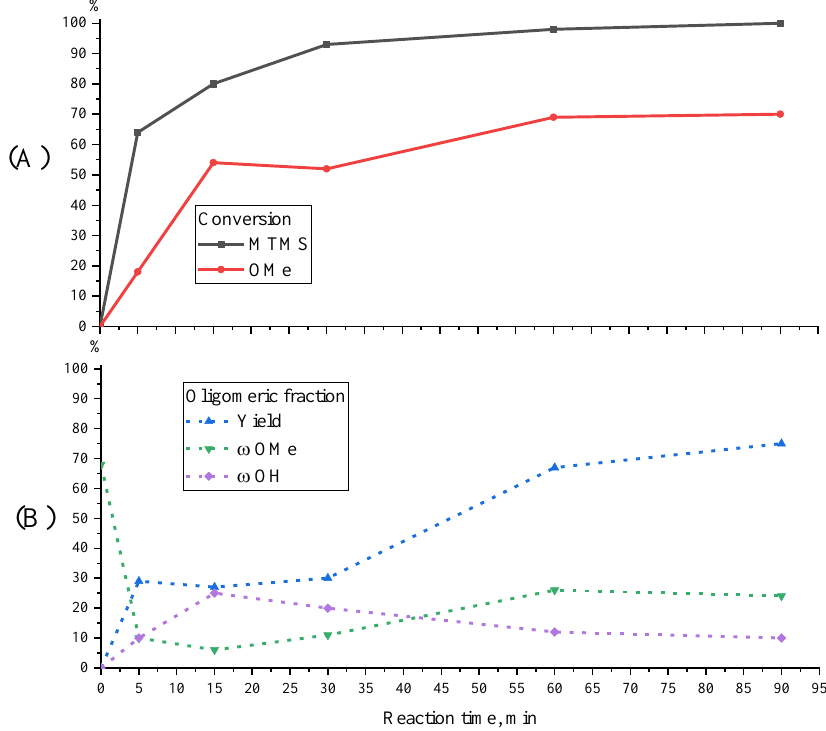
Figure 9. Curves of monomer and MeO-group conversions ( A ) and parameters of oligomeric fraction ( B ) obtained by MTMS MWHP at different radiation times and a MTMS/H 2 O molar ratio of 1/1.5 at 30 ◦ C, 20 W (Samples 3, 7–10, Table 1).